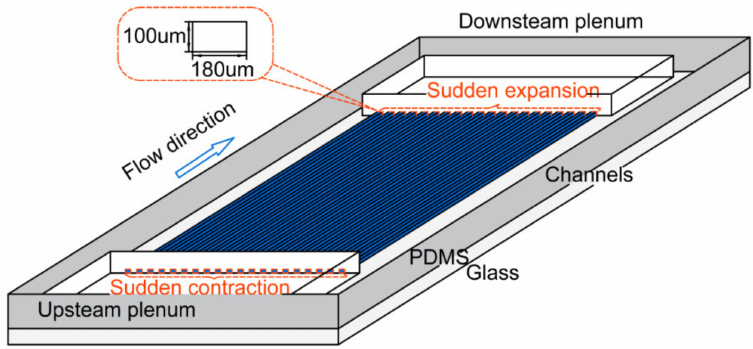
Figure 6. Superhydrophobic straight